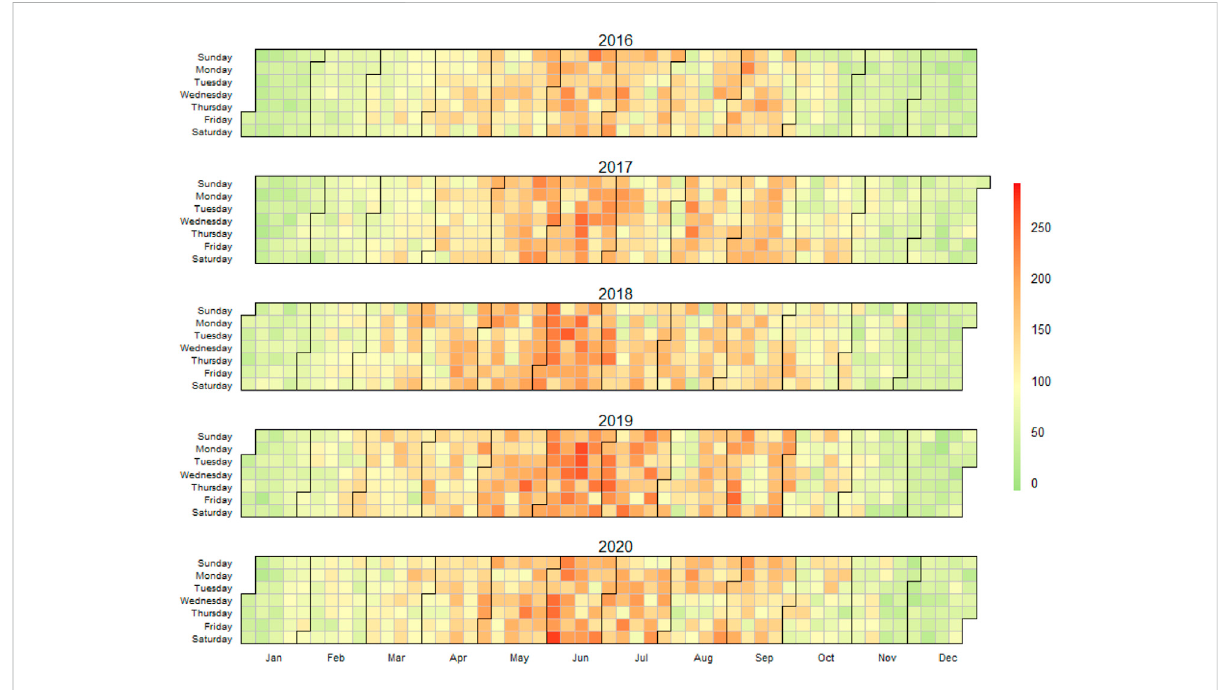
FIGURE 2 Calendar heat map of MDA8 ozone of Zibo city during 2016 –